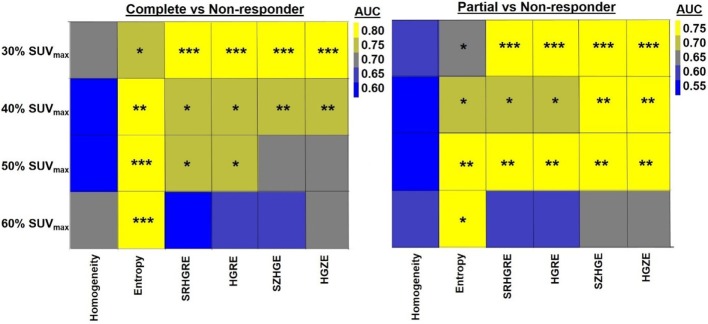
Heatmap shows the quantification (AUC) of the relationship between ΔTexture and pathologic response with the metabolic tumor volumes (MTV) of >30, 40, 50, and 60% SUVmax. * indicates 0.005 < p < 0.05, ** indicates 0.0005 < p < 0.005, *** indicates p < 0.0005. HGRE, high-gray-run emphasis; HGZE, high-gray zone-run emphasis; SRHGRE, Short-run high-gray-run emphasis; SZHGE, short-zone high-gray-run emphasis.